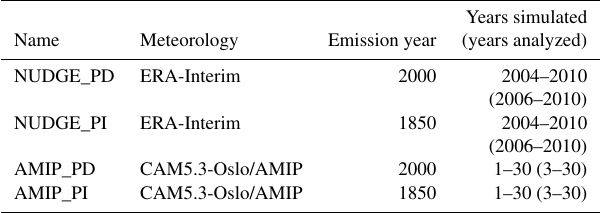
Table 3. Overview of the experiments in this study. Note that the land model (CLM4.5) setup is for a PD climate, so BVOC emis- sions are based on PD land use. All simulations have been run with 0.9 ◦ × 1.25 ◦ horizontal resolution and with 30 layers in the